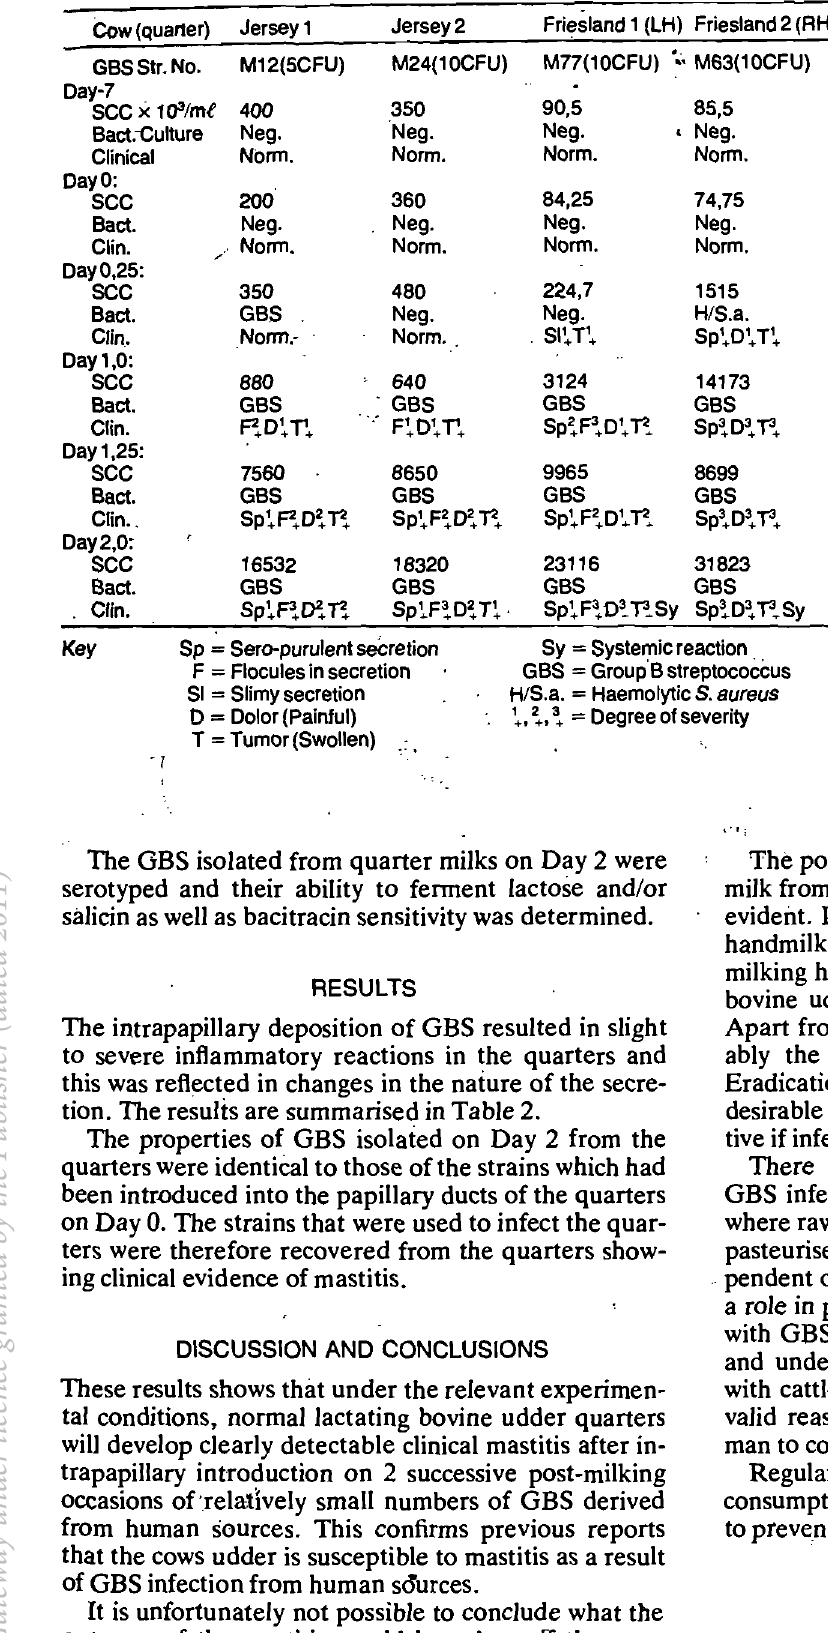
Table 2: SUMMARY OF DATA OBTAINED BEFORE ANI:? AFTER INTRAPAPILLARY DEPOS ITION (ON DAY 0) OF SPECIFIED STRAINS OF , · G B S OF HUMAN